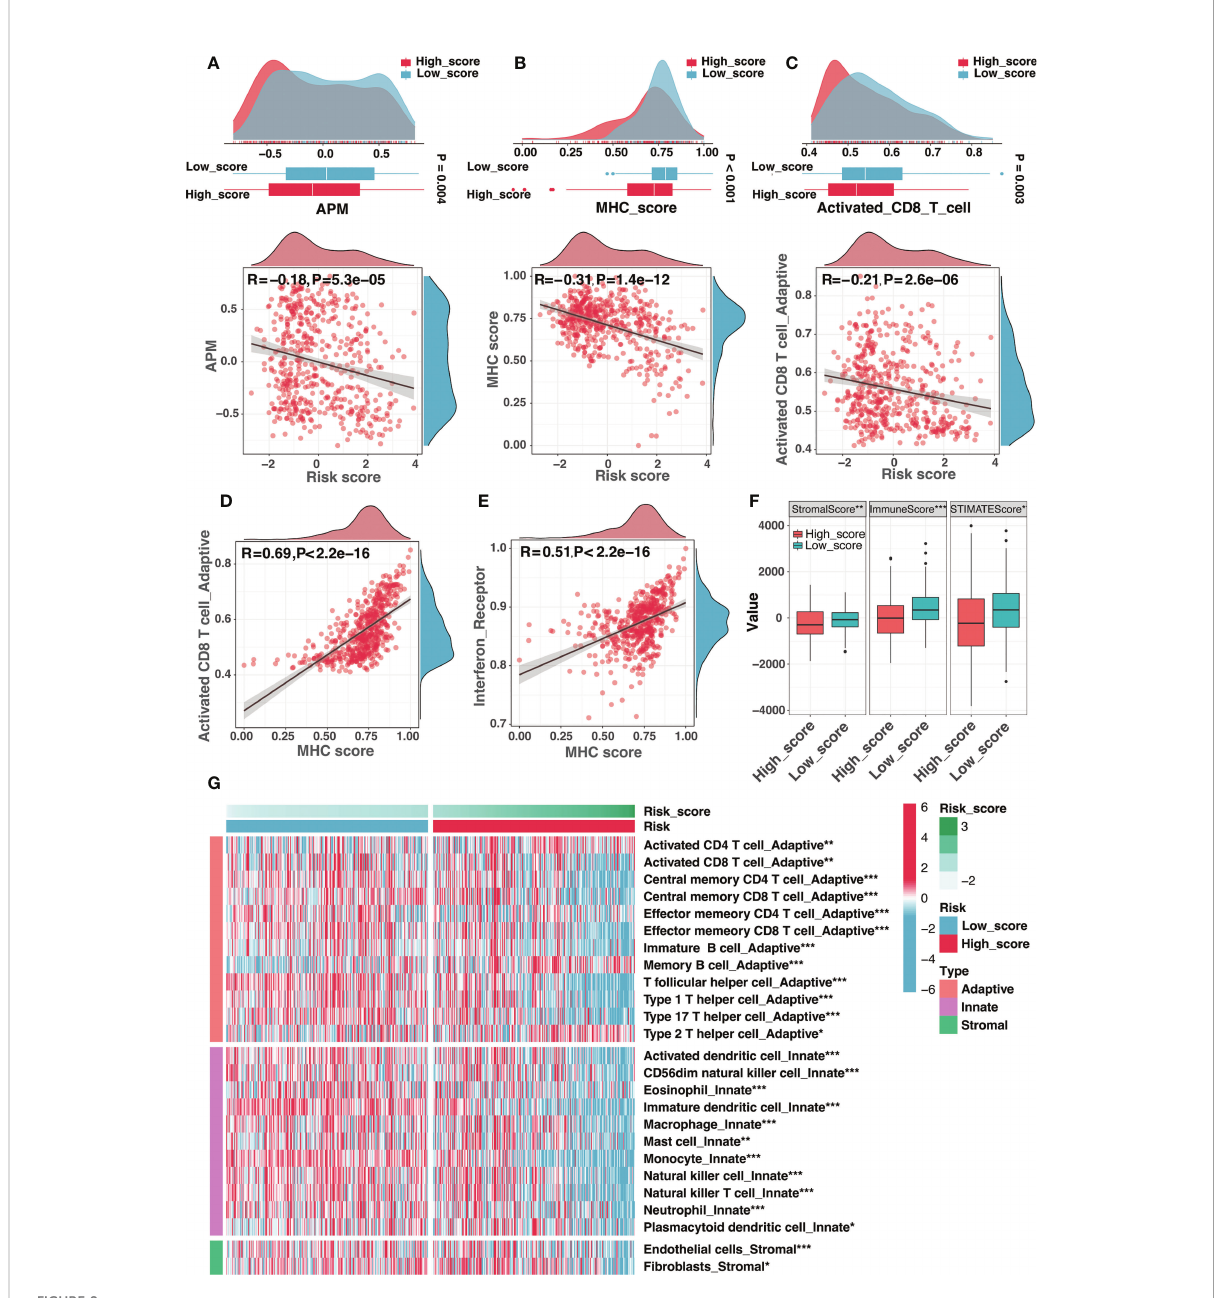
FIGURE 8 The immune landscape of the risk signature. (A) The comparison of antigen-presenting machinery (APM) score between different risk groups (top) and correlation analysis between the risk score and the APM score (bottom). (B) The comparison of MHC score between different risk groups (top) and correlation analysis between the risk score and the MHC score (bottom). (C) The comparison of activated CD8 T cell in fi ltration between different risk groups (top) and correlation analysis between the risk score and the activated CD8 T cell in fi ltration (bottom). (D, E) The correlation analysis between the MHC score and the activated CD8 T cell in fi ltration (D) as well as interferon receptor activity (E) . (F) Comparison of the stromal, immune, and ESTIMATE scores between high-score and low-score groups. (G) Different in fi ltration levels of immune in fi ltrating cells between low-score and high-score groups. (*:P< 0.05, **: P < 0.01, ***: P <